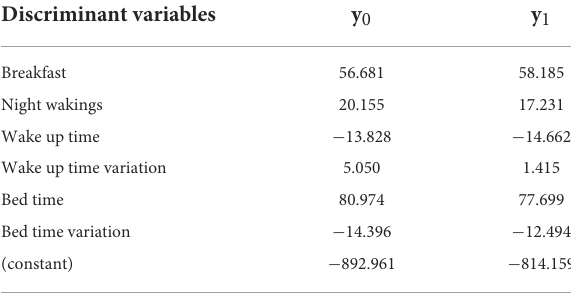
TABLE 8 Fisher function coefficients of 19–47 months age group.